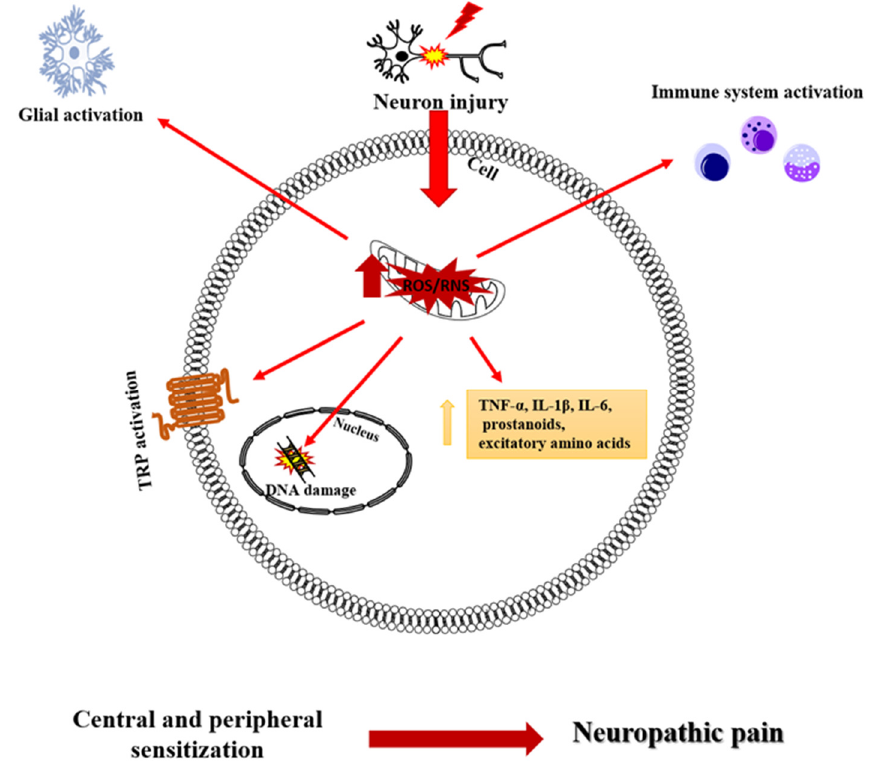
Figure 1. Free radical action following nerve injury.